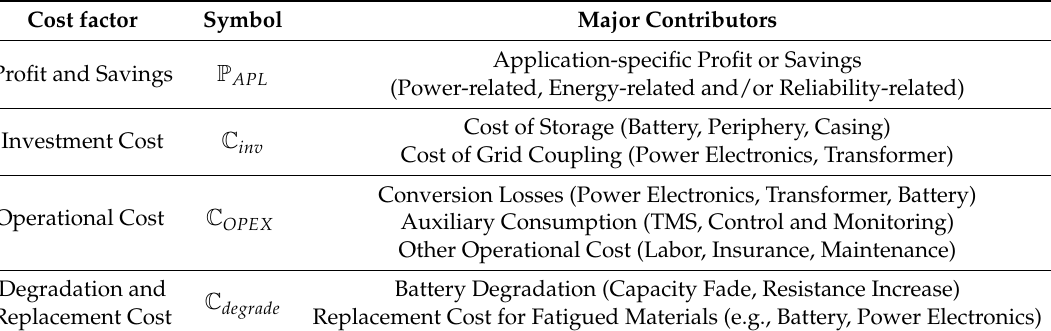
Table 1. Overview to cost and profitability drivers for a technically oriented valuation of stationary storage